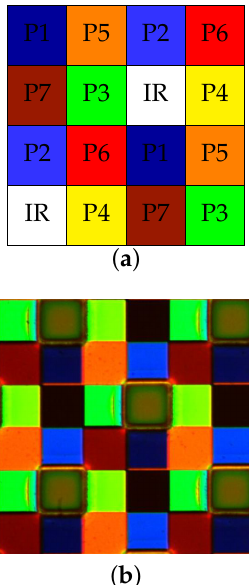
Figure 4. Visualization of moxel spatial arrangement. ( a ) Moxel arrangement for P 1– P 7, NIR channels. It shows uniformly distributed samples as an instance of Miao et al. [46,47] binary tree algorithm; ( b ) Microscope image of the MSFA filters after they are manufactured and before to mount them on the